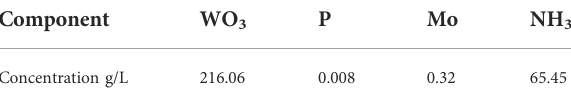
TABLE 3 Main composition of the ammonium tungstate solution after phosphorus